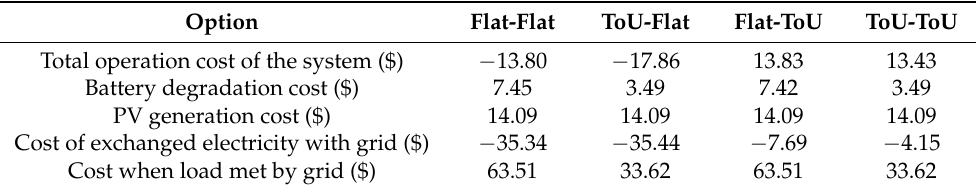
Table 5. Key performance indicators (KPIs) for comparison of economic analysis of the proposed EMSs for one week in summer under four options. Option Flat-Flat ToU-Flat Flat-ToU ToU-ToU Total operation cost of the system ($)